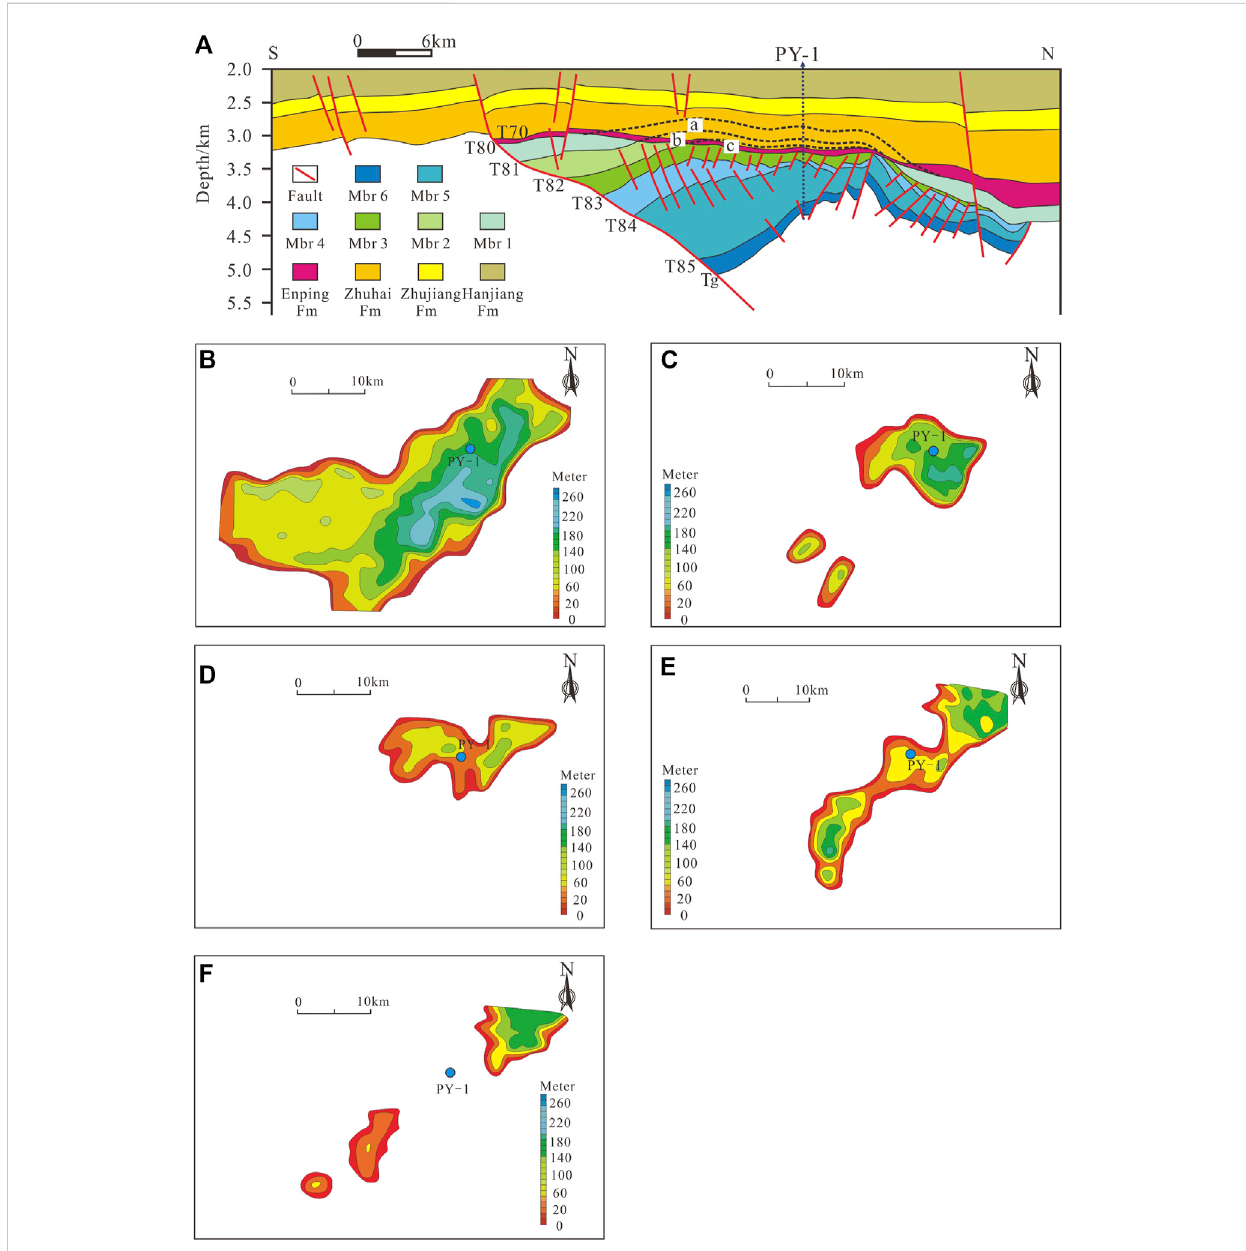
FIGURE 8 (A) The principle of structural trend extrapolation to restore erosion amount. (A) Eroded thickness of Member 1; (B) Eroded thickness of Member 2; (C) Eroded thickness of Member 3; Mbr - Member, Fm - Formation. The eroded thickness recovery from Member 1 to Member 5 [from (B – F) ] in Panyu 4